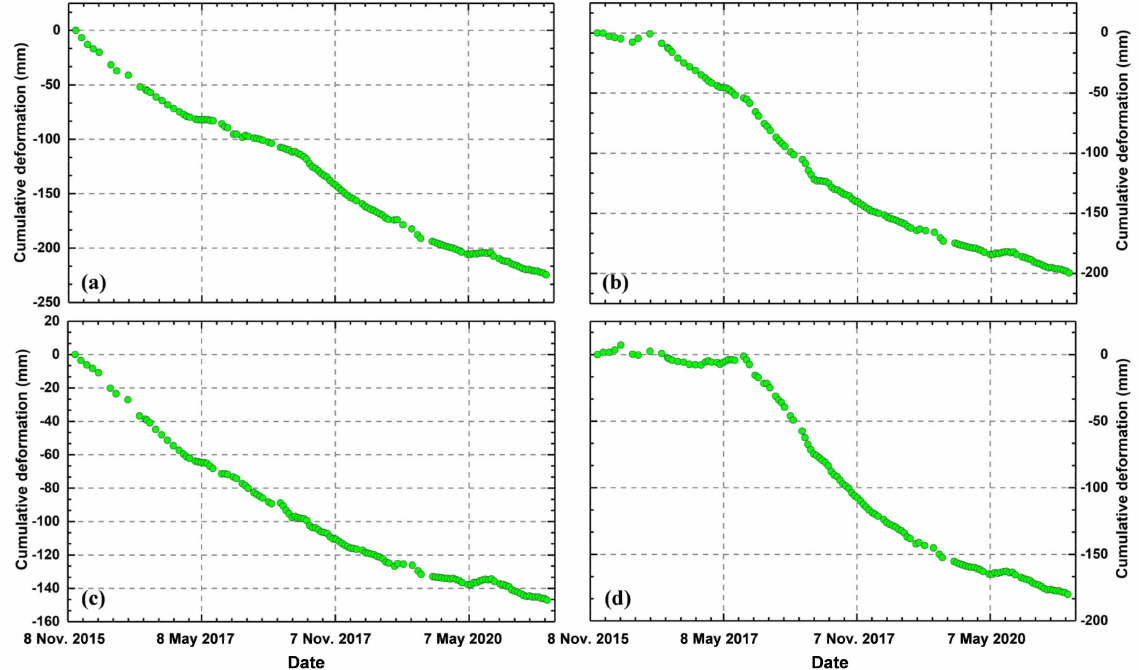
Figure 24. Time series of surface displacement at Points P7–P10 from December 2015 and March 2021. The locations of Points P7–P10 are marked in Figure 22. ( a ) Displacement time series for Point P7 marked in Figure 22b; ( b ) displacement time series for Point P8 marked in Figure 22b; ( c ) displacement time series for Point P9 marked in Figure 22c; ( d ) displacement time series for Point P10 marked in Figure